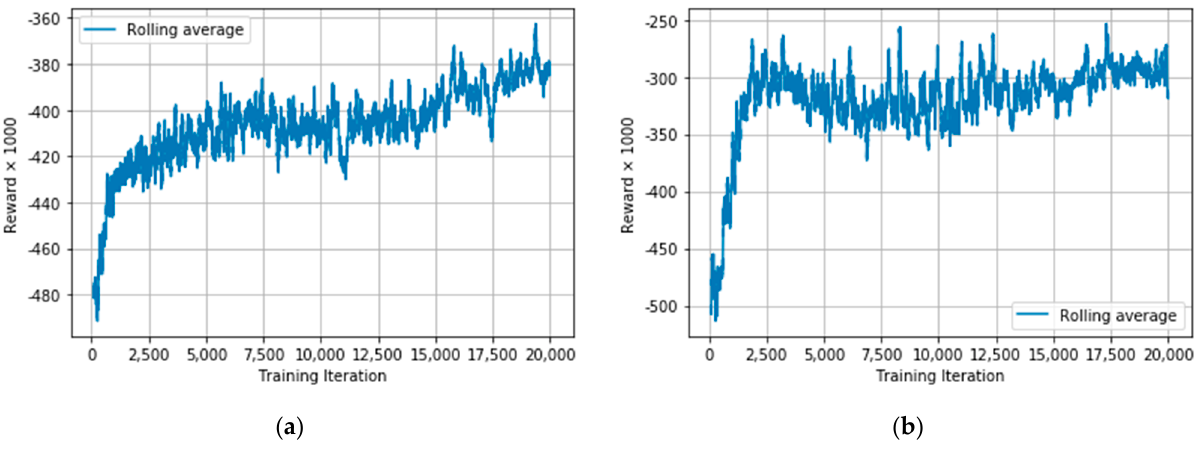
Figure 7. Training curve showing reward convergences for episode number 0 to 20,000; ( a ) trading algorithm ( b ) non- trading algorithm.